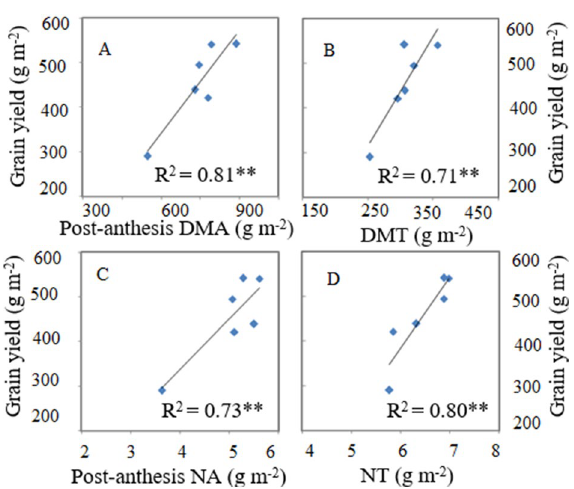
Figure 6. Linear relationships of grain yield with post-anthesis DMA ( A ), dry matter translocation ( B ), post- anthesis NA ( C ), and nitrogen translocation ( D ). Note:DMA- dry matter acuumulation, DMT- dry matter translocation, NA-nitrogen accumulation, NT- nitrogen translocation. ** p < 0.001. n =